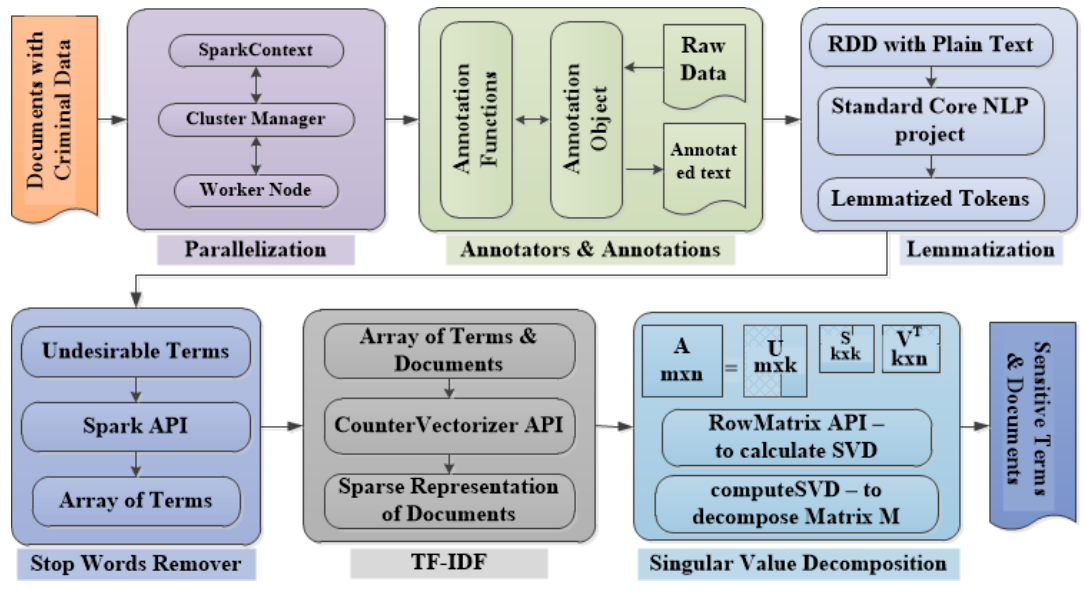
Figure 1. An overview of the proposed method.